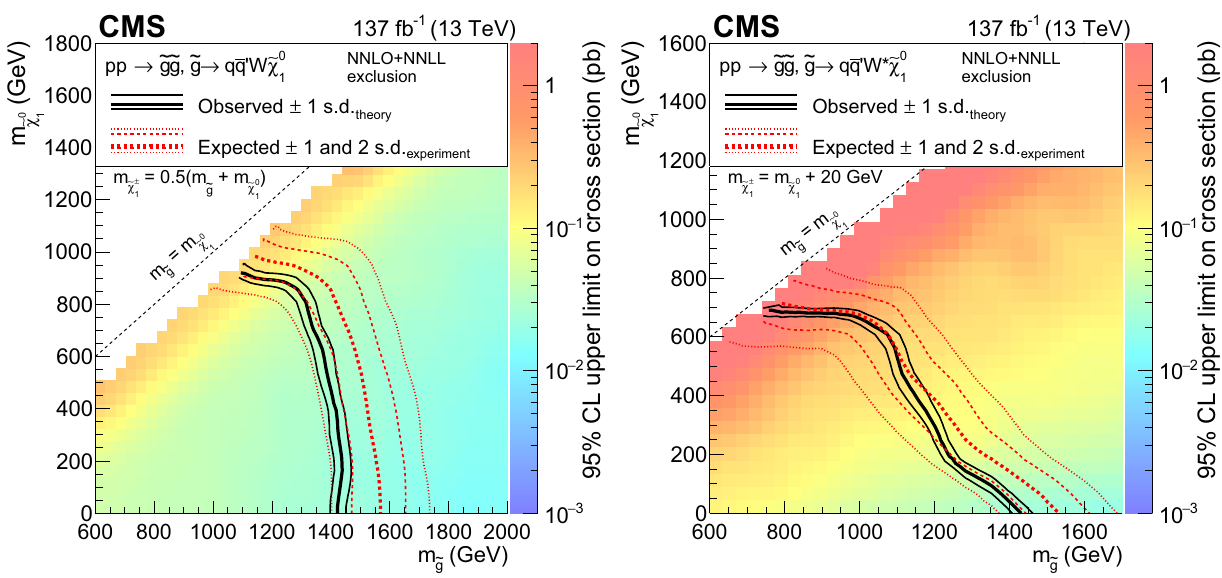
Fig. 8 Exclusion regions at 95% CL in the plane of m ˜ χ 0 = m + 20GeV (right). The notations are as in Fig. 7 m ˜ χ ± ˜ χ 0 1 1